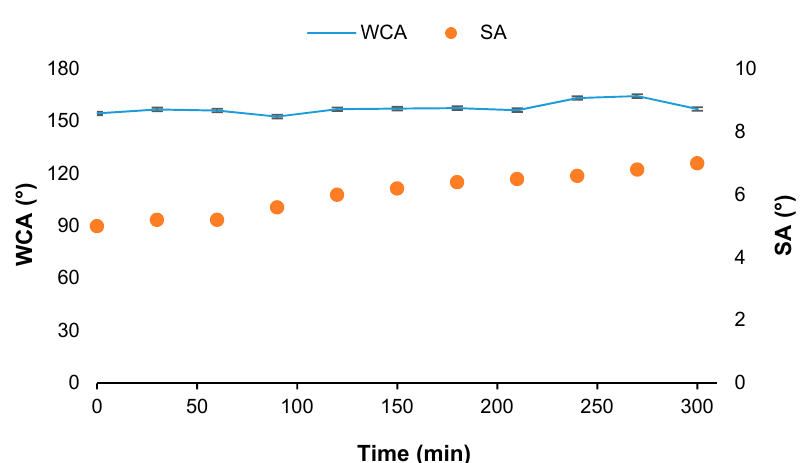
Figure 10 . After several cycles of UV light test the WCA is not affected at all, which denotes a high stability of the coating under energetic light. SA increases slightly but it still presents self-cleaning properties after 300 min under UV light exposure.